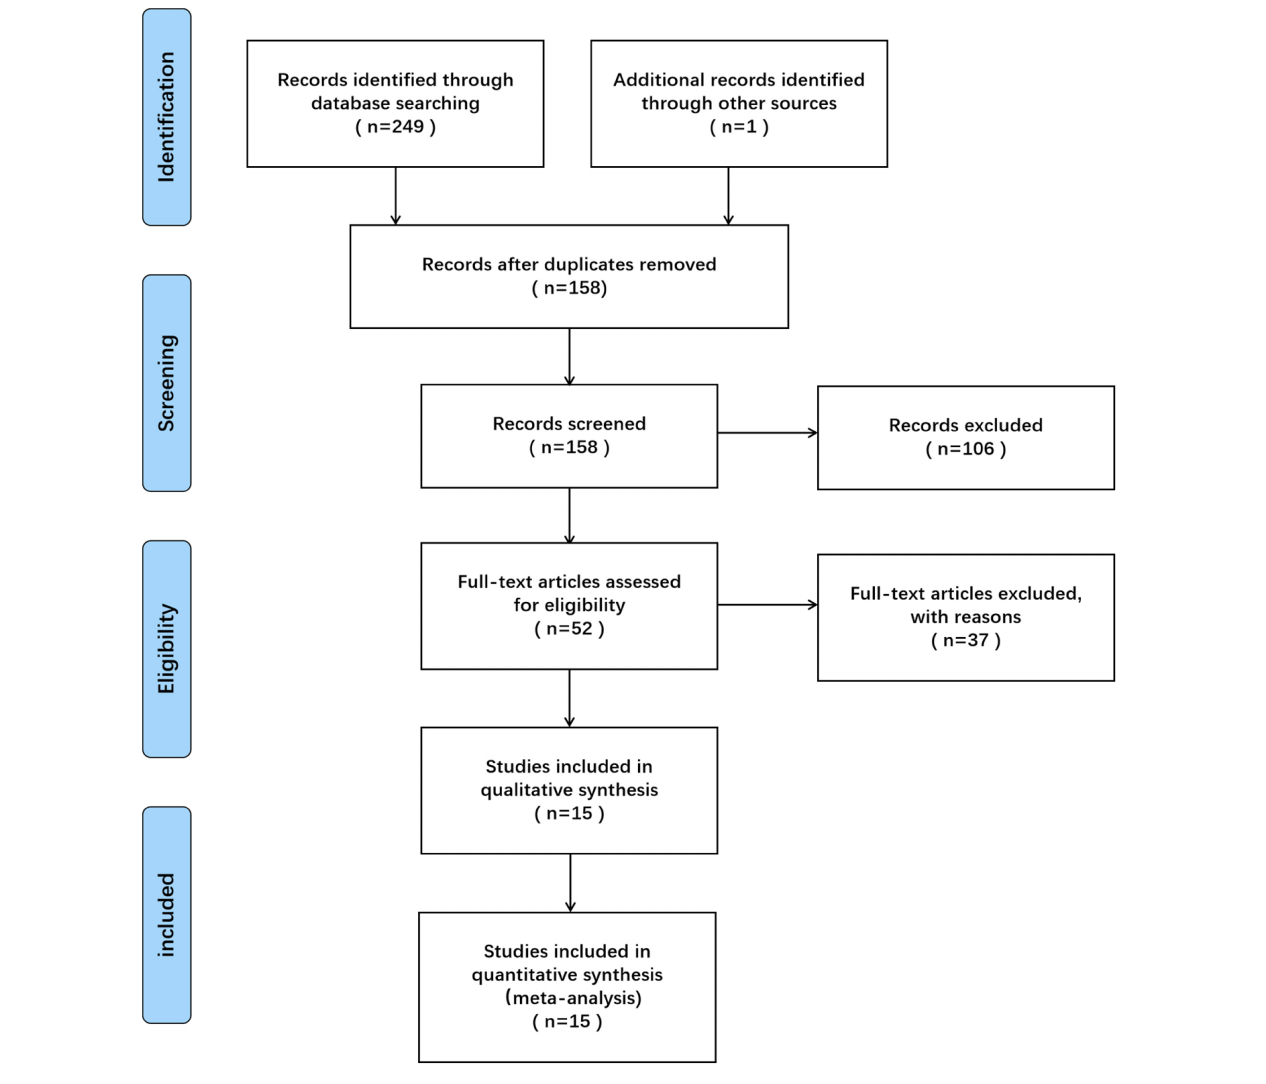
FIGURE1 Preferred reporting items for systematic reviews and meta-analyses (PRISMA) flow diagram of study